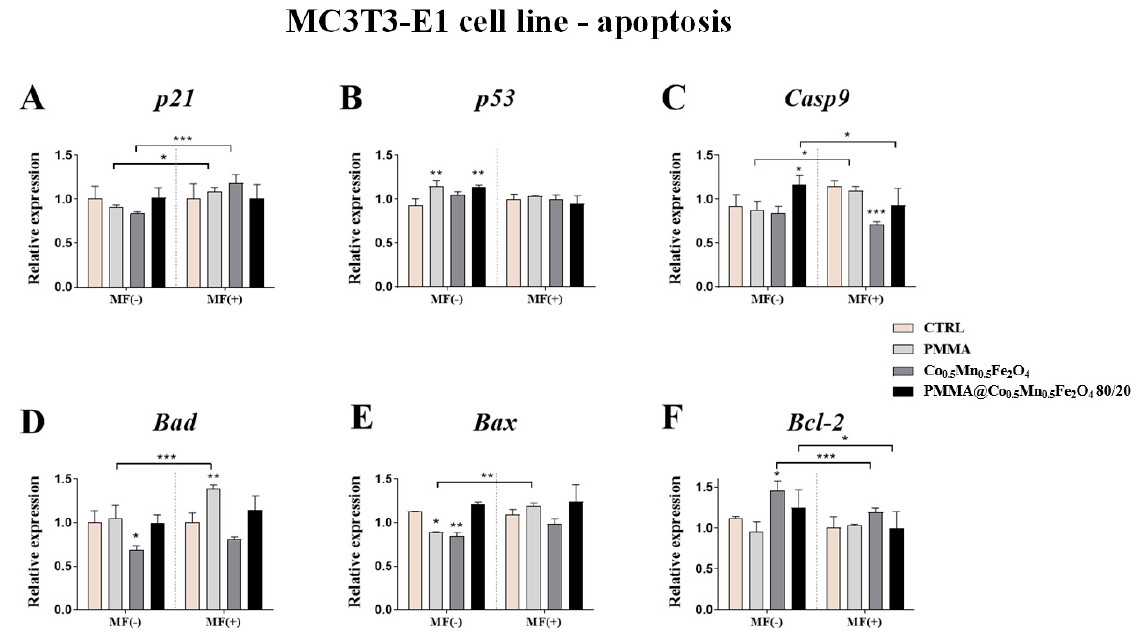
Figure 5. The impact of PMMA and its modification on the expression of genes related to apoptosis: ( p21 ( A ), p53 ( B ), Casp-9 ( C ), Bad ( D ), Bax ( E ) and Bcl-2 ( F )) in the magnetic field condition towards mouse pre-osteoblasts (MC3T3-E1 cell line). Statistical differences are indicated by * p < 0.005; ** p < 0.001 and *** p < 0.0001. The effect of PMMA alone on the pre-osteoclasts expression of genes associated with apoptosis was similar in the MF(+) and MF( − ) conditions. The significant decrease in the expression of p21 and Bad in the MF( − ) condition, as well as the decrease of the expression of p21 in the MF(+) condition, was observed (Figure 6A,D).